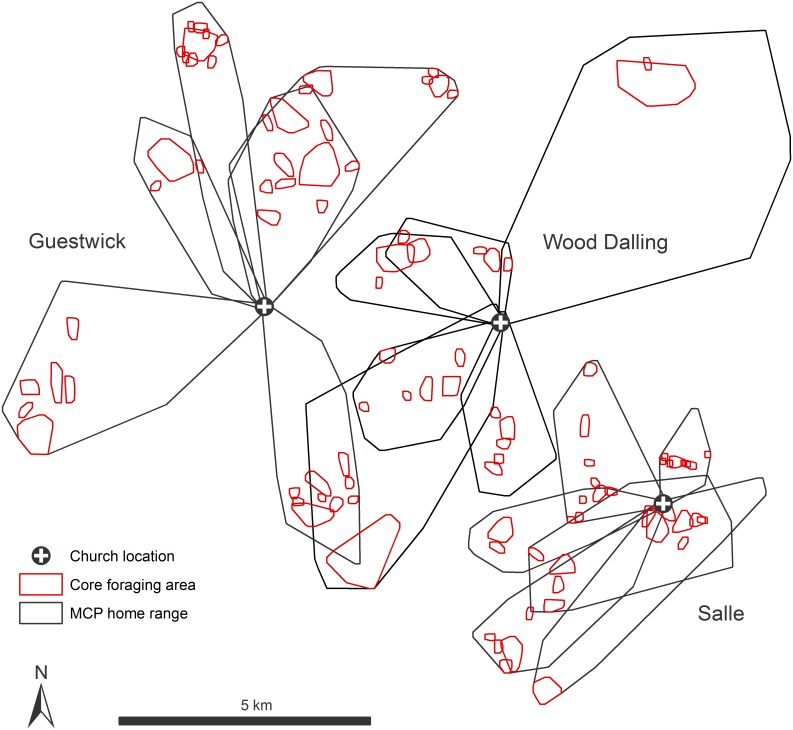
Examples of individual bat home range areas and core foraging areas from 18 adult female Myotis nattereri.The black polygons denote 100% MCP home ranges and the red polygons 80% cluster cores. Data are from 18 bats radio-tracked at three churches (Guestwick, Salle and Wood Dalling; n = 6 bats per site).